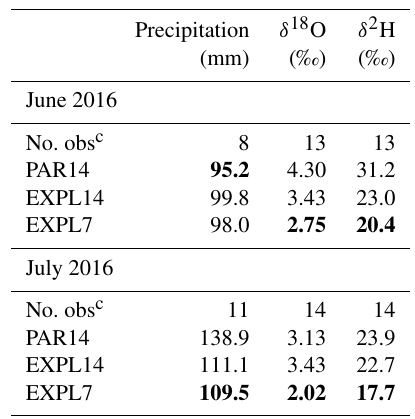
Table 2. RMSE of precipitation in the three COSMO iso experi- ments compared with GNIP observations a , b .